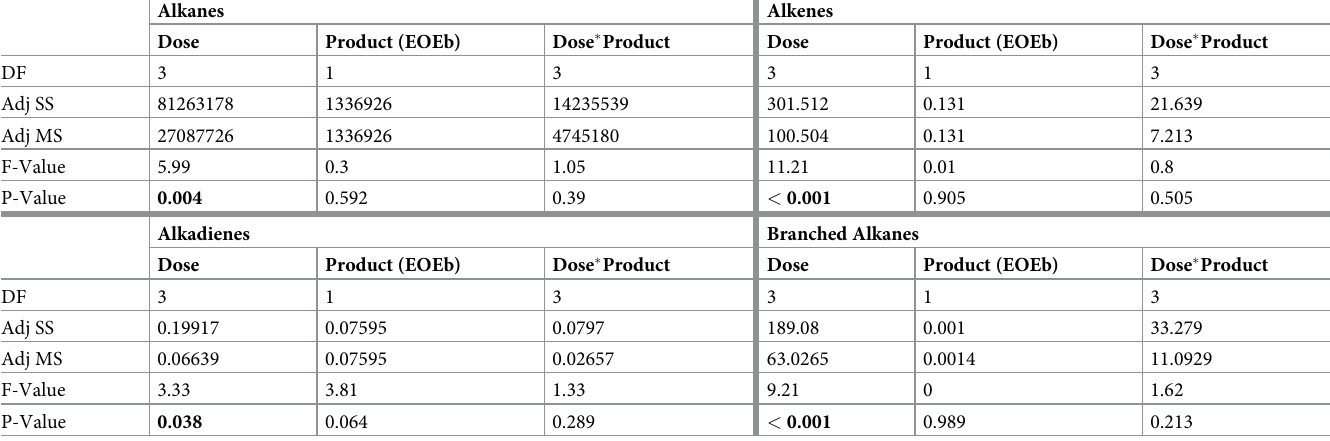
Table 1. Results on the analysis of variance (GLM) for groups of CHC from healthy honeybees fed on 2 EOEb at different doses (0, 300, 3000, 6000 ppm; Experiment I).